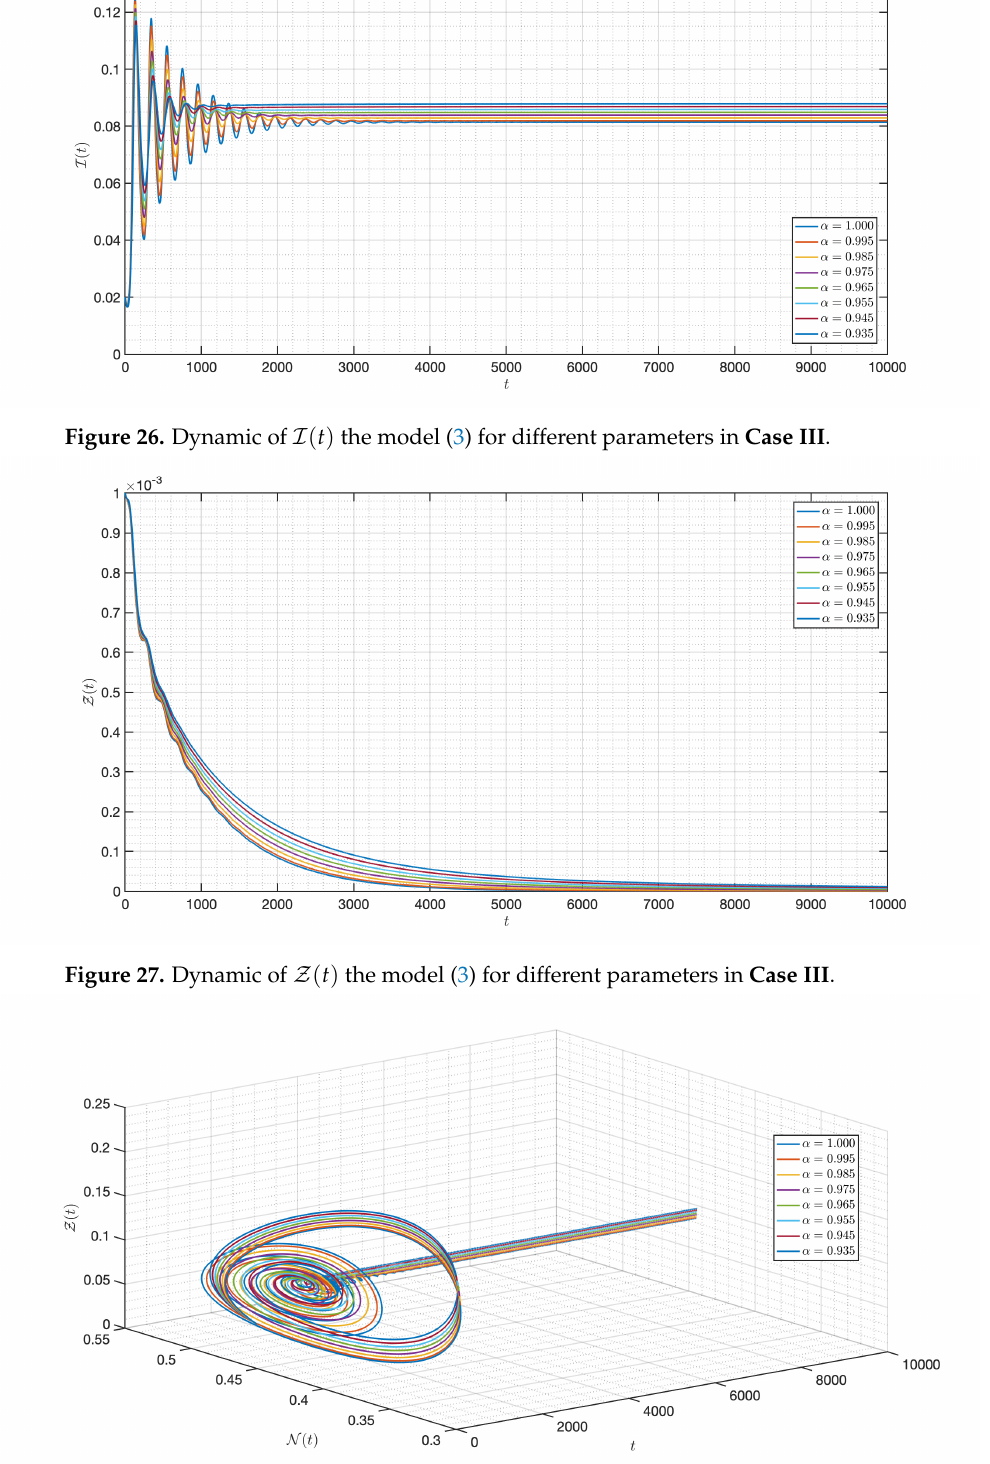
Figure 28. Dynamic of the model (3) for different parameters in Case III